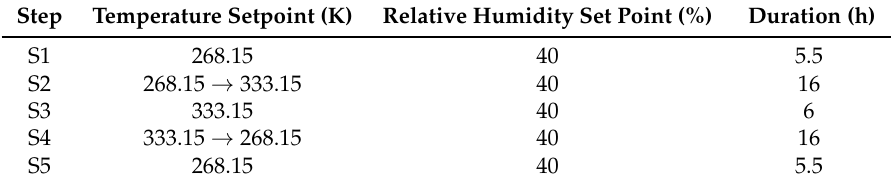
Table 2. Imposed hygrothermal cycle.